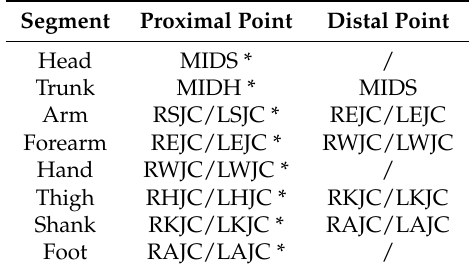
Table 1. Proximal and distal points for each body segment. * indicates the origin of the reference frames attached to each body segment, while / indicates that the distal point is not defined, as it is not necessary for the model construction.